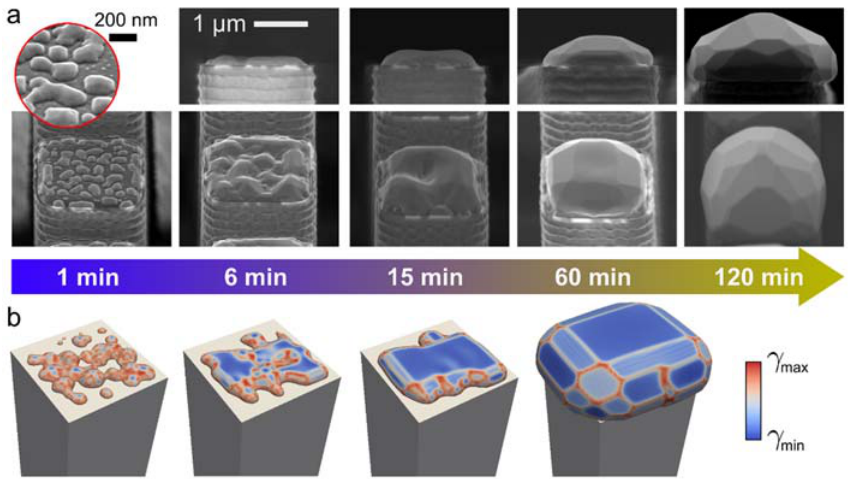
Figure 4. Growth sequence of a Ge micro-crystal on a 2 × 2 µ m 2 Si pillar by RPCVD. ( a ) Lateral and perspective SEM views of samples after deposition of different duration. Multiple crystal seeds are observed at the early stages, coalescing into a single faceted structure later on. ( b ) Profiles obtained by a phase-field simulation of crystal growth, matching the experimental behavior. Reproduced with permission from [21]. American Chemical Society.